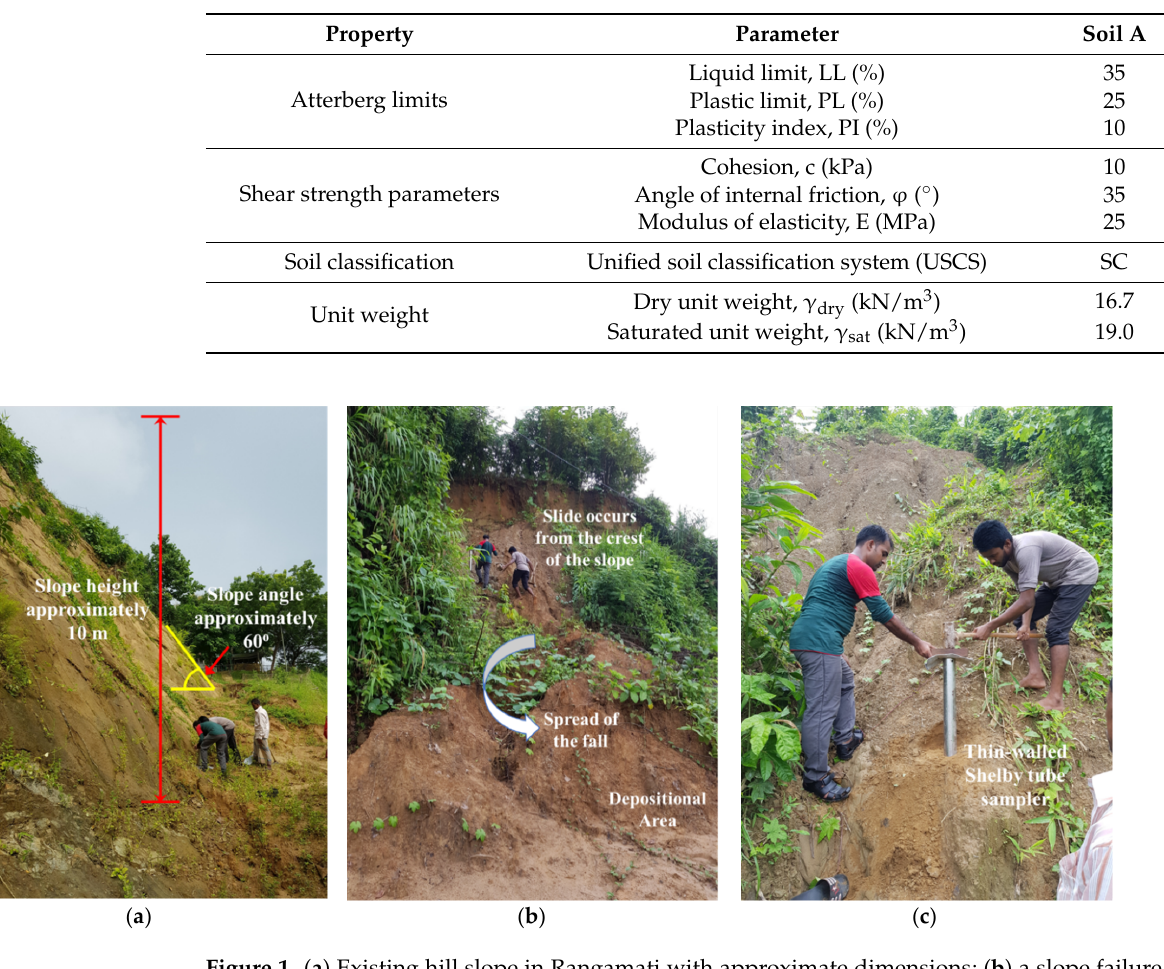
Figure 1. ( a ) Existing hill slope in Rangamati with approximate dimensions; ( b ) a slope failure in Rangamati occurred in 2017; ( c ) soil sample collection using thin walled Shelby tube (all photos were taken by Md Azijul Islam). Table 1. Properties of the soil used in this study.